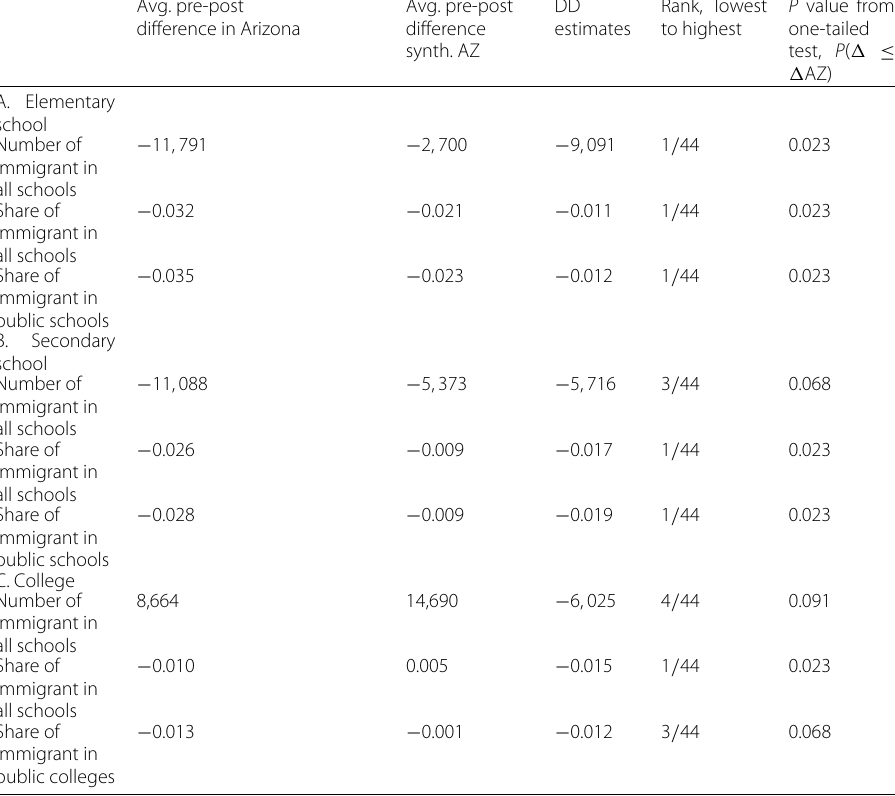
Table 1 LAWA and size of foreign-born population in Arizona’s education system